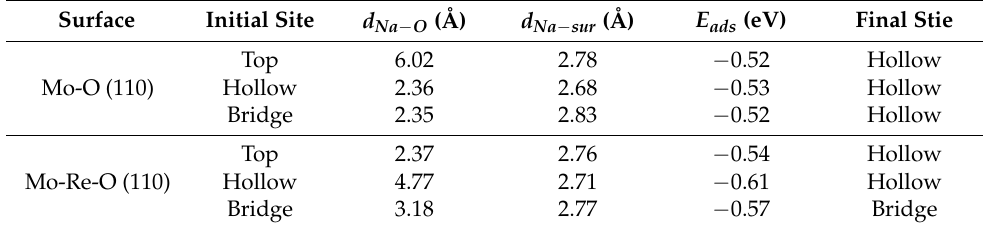
Figure 6. The initial and final configurations of Na atom adsorption on Mo-O (110) and Mo-Re-O (110) surface. Snaps ( a – c ) show Na atoms initially placed at Top site, Hollow site and Bridge site of Mo-O (110) surface, while snaps ( d – f ) show Na atoms initially placed at Top site, Hollow site and Bridge site of Mo-Re-O (110) surface. Blue and green spheres represent Mo atoms in the first layer and the second layer. Yellow, purple and red spheres represent Re atoms, Na atoms and O atoms, respectively. Table 4. Na adsorption energy on different surface